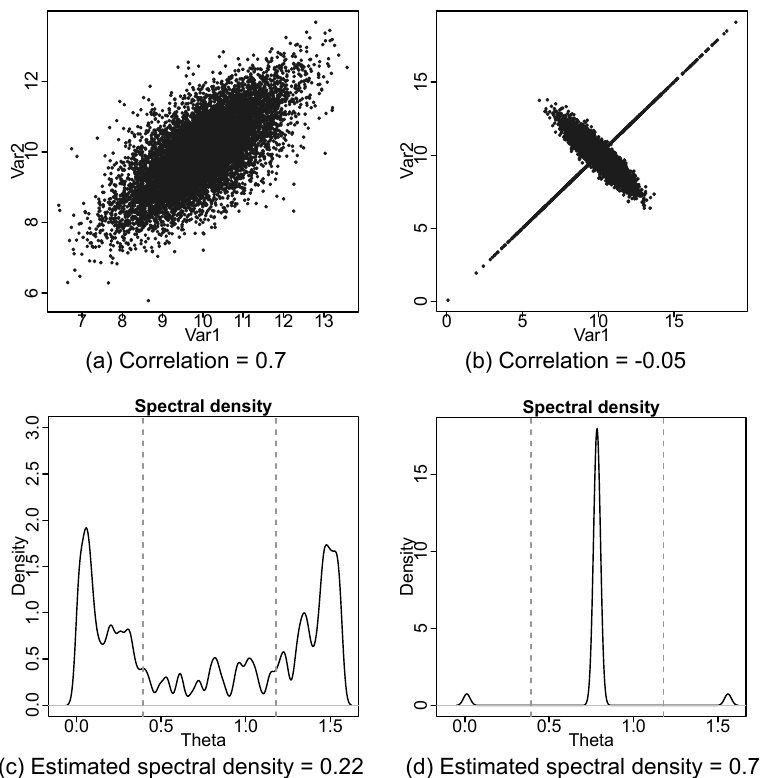
(d) Estimated spectral density = 0.75(c) Estimated spectral density = 0.22 Figure 1. Examples that show the correlation and extremal measure of dependence between two variables are not necessarily the same. The plots in the left column (a, c) use the data generated by Gaussian random vectors with correlation ρ = 0 . 7 and each component has n = 10000 points sampled from N( 10 , 1 ) , where N(µ,σ 2 ) is the normal distribution with mean µ and variance σ 2 . The data are moderately correlated, while they have low extreme dependence (true ϕ = 0; estimated ϕ = 0 . 223). The plots in the right column (b, d) use the data generated by ( Var 1 , Var 2 ) = (Y 1 ,Y 2 ) with probability 0.8 and ( Var 1 , Var 2 ) = (Z,Z) with probability 0.2, where (Y 1 ,Y 2 ) ∼ N (cid:0) µ = [ 10 , 10 ] T , (cid:54) = [ 1 , − 0 . 9 ;− 0 . 9 , 1 ] (cid:1) follows a bivariate normal, µ is the mean vector and (cid:54) is the covariance matrix, and Z ∼ N(µ = 10 ,σ 2 = 9 ) . The ( ϕ = 0 . 75); however, sample size is also n = 10000. The plots show the existence of tail dependence by having high angular density near π 4 there is low correlation (true ρ = 0; estimated ρ = − 0 .